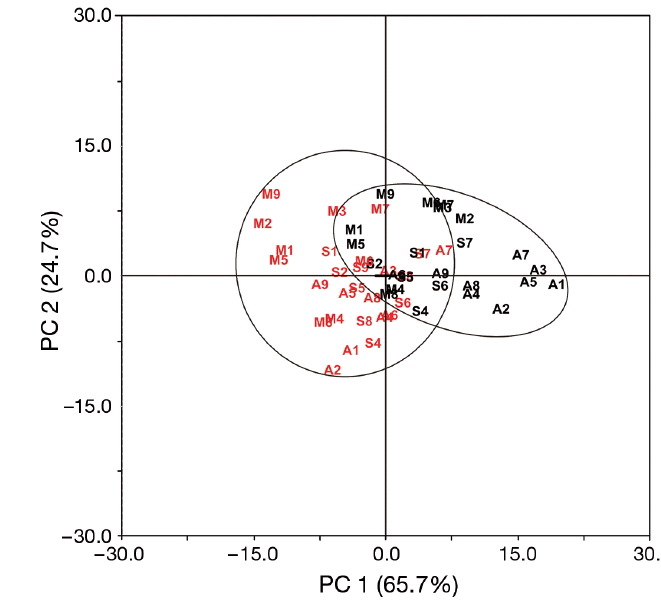
Fig. 3. Salmo salar . Score plot of principal component (PC) analy- sis of levels of fatty acid methyl esters (FAME) in total lipids (black) or triacylglycerols (red) in the adipose fin (A), snout (S) and muscle (M) samples of wild salmon. Numbers in the alpha-